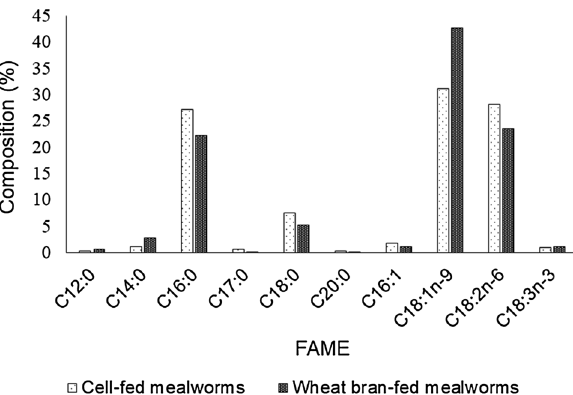
Figure 2. Fatty acid methyl ester composition (%) of the extracted lipid from mealworms fed with bacterial cells and wheat